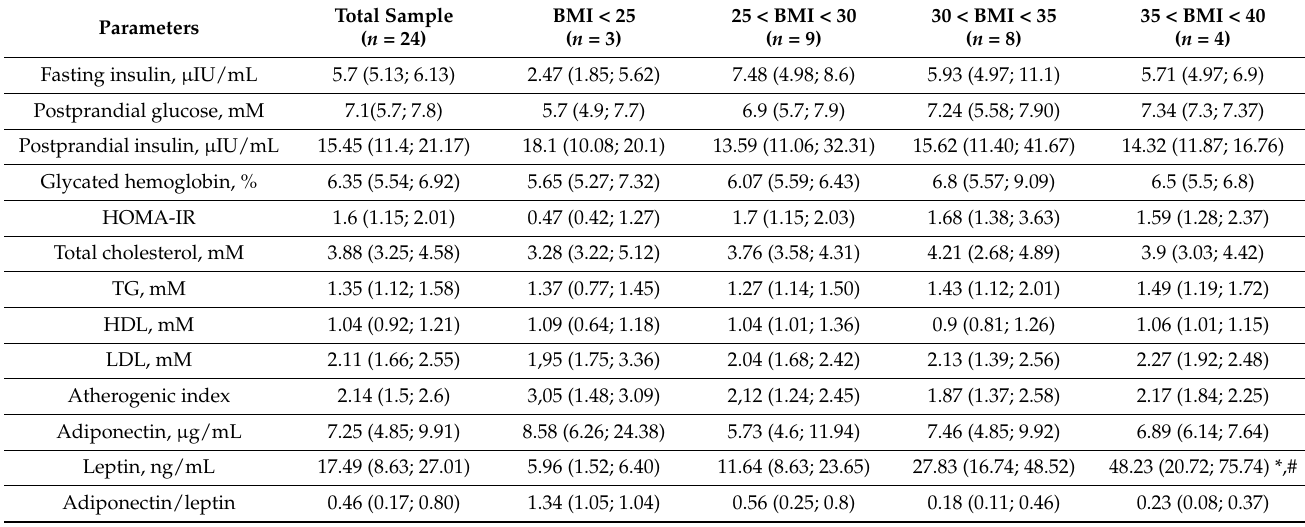
( B ) Figure 2. The representative snapshots of EAT adipocytes of patients from groups of patients with non-hypertrophied EAT adipocytes and with hypertrophied EAT adipocytes. ( A ) Patient from group of patients with non-hypertrophied EAT adipocytes, median of adipocytes diameter is 80.27 μ m; ( B ) patient from group of patients with hypertrophied EAT adipocytes, median of adipocytes diameter is 89.88 μ m. Light microscopy, magnification × 200. EAT, epicardial adipose tissue.